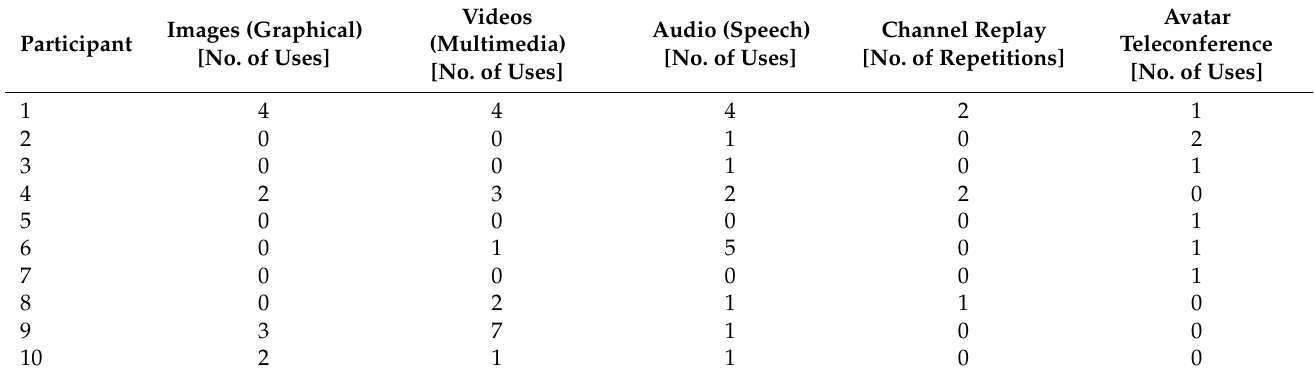
Table 1. Summary of the number of the information channel changes by the